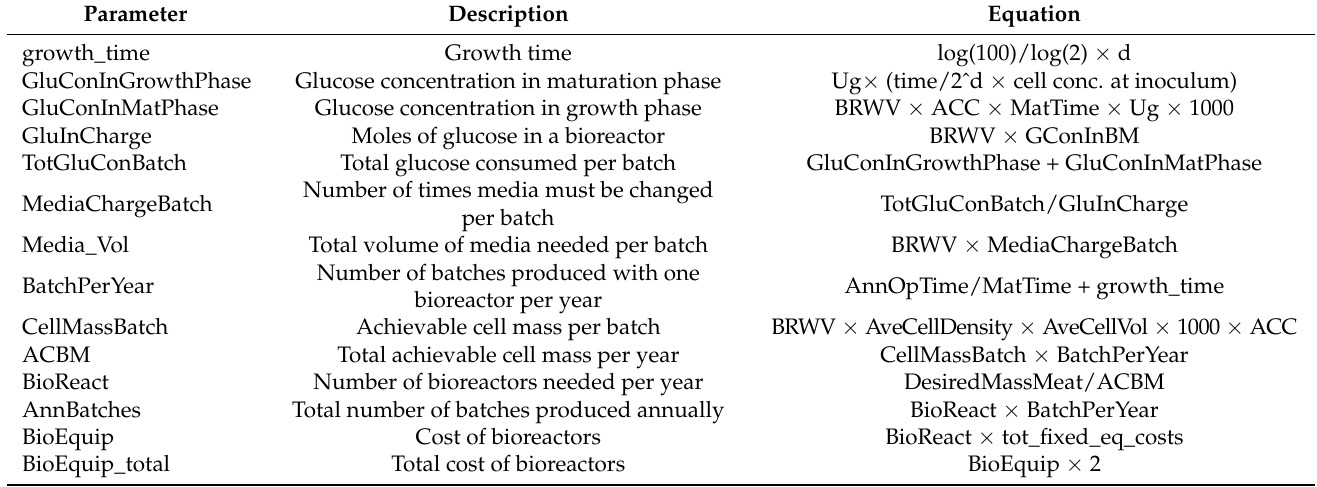
Table A2. Parameters calculated within ACBM cost calculator code. Parameter names are shown as they are written in the code accompanied by descriptions and equations